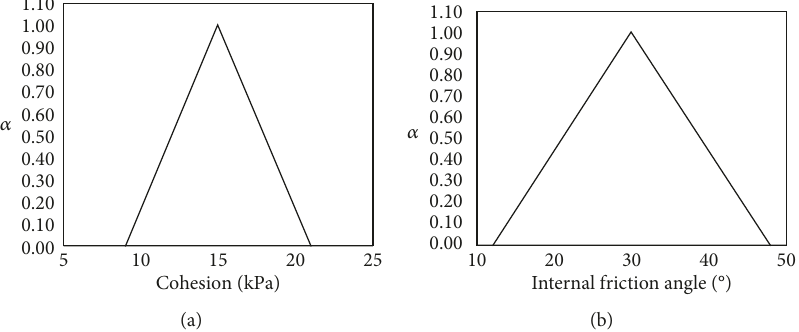
Figure 6: Fuzzy number of (a) cohesion and (b) friction angle of silt soil. Table 3: α -Cut value of loam soil and silt soil.